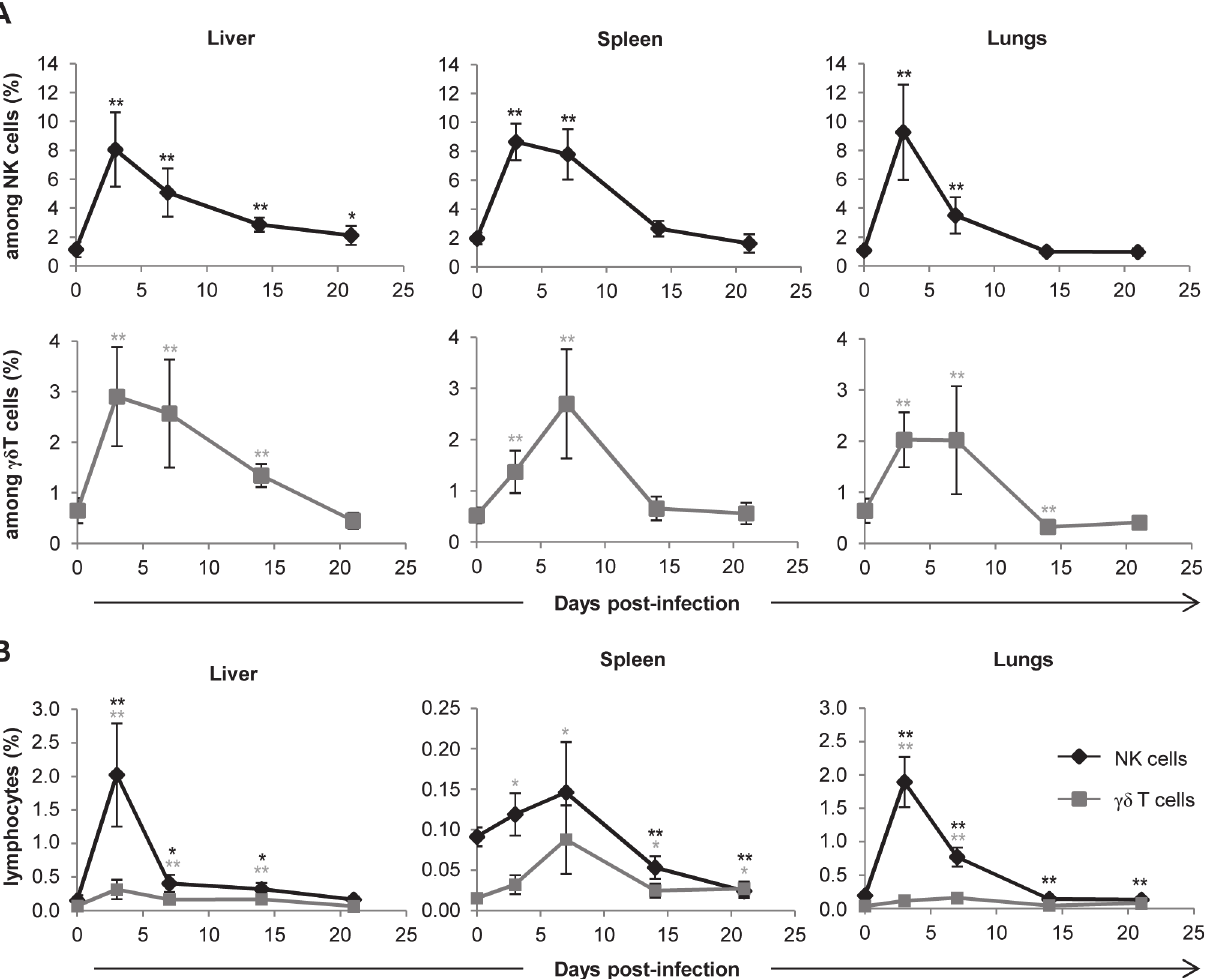
Fig 7. γδ T cells are not the main producers of IFN γ during early acute MCMV infection. TCR α − / − mice were infected i.p. with 2.10 3 PFU of MCMV. At indicated days post-infection, 6 – 8 mice were sacrificed and immune cells were isolated from each organ for ex-vivo analysis of IFN γ production by live (7AAD − ) CD3 ε − NKp46 + and CD3 ε + γδ + cells. A . Proportions of IFN γ producing cells for each NK or γδ T cell subtype are shown. B . Percentages of IFN γ producing NK and γδ T cells among lymphocytes. Data are from 1 representative of 2 independent experiments and are expressed as mean percentages ± SEM of 6 – 8 mice. Statistical differences between day 0 and other time points are shown.